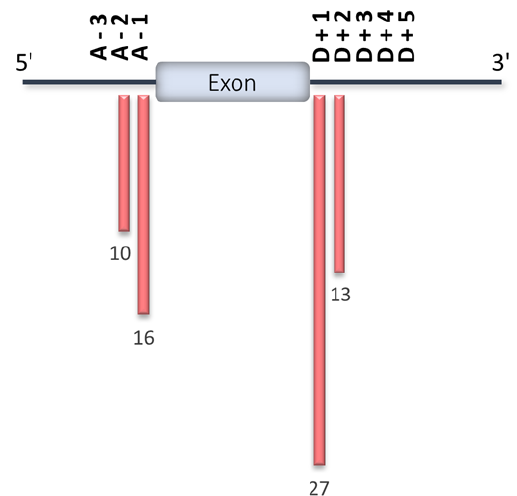
Figure 6. HCM splice site mutations reported in the ClinVar database. Position of splice site mutations reported in the ClinVar database for the eight HCM-associated genes shown in Figure 5. The number of variants per position is indicated. The 5′ splice site (ss) is also known as the donor (D) splice site, whereas the 3' site is also known as the acceptor (A) splice site. Position D + 1 corresponds to the first intronic nucleotide downstream of the depicted exon, D + 2 to the second, and so forth. Position A-1 corresponds to the last intronic nucleotide upstream of the depicted exon, A-2 to the previous one, and so